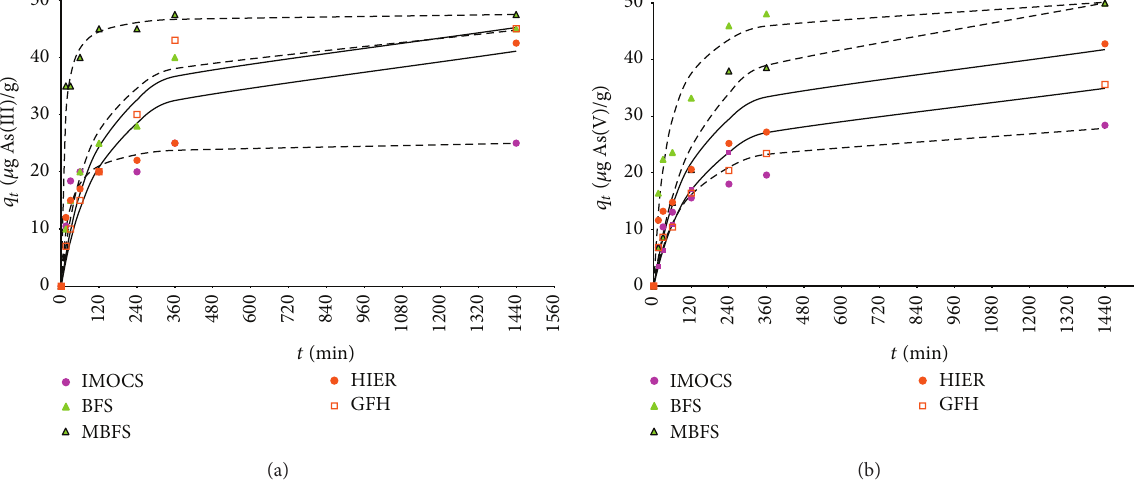
Figure 3: Sorption kinetics modelling of As(III) and As(V) on industrial by-products and commercial sorbents (pseudo-second-order